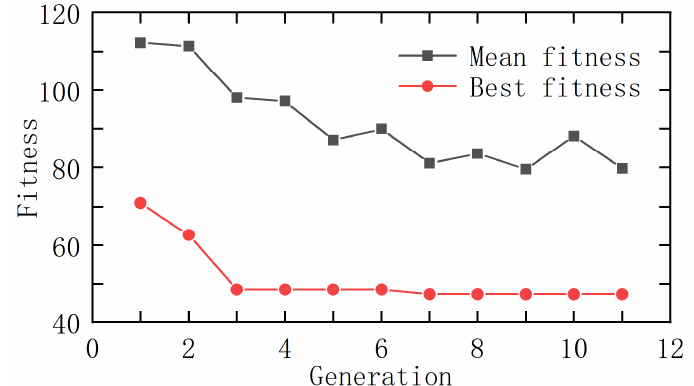
Figure 6. The evolution of fitness function.